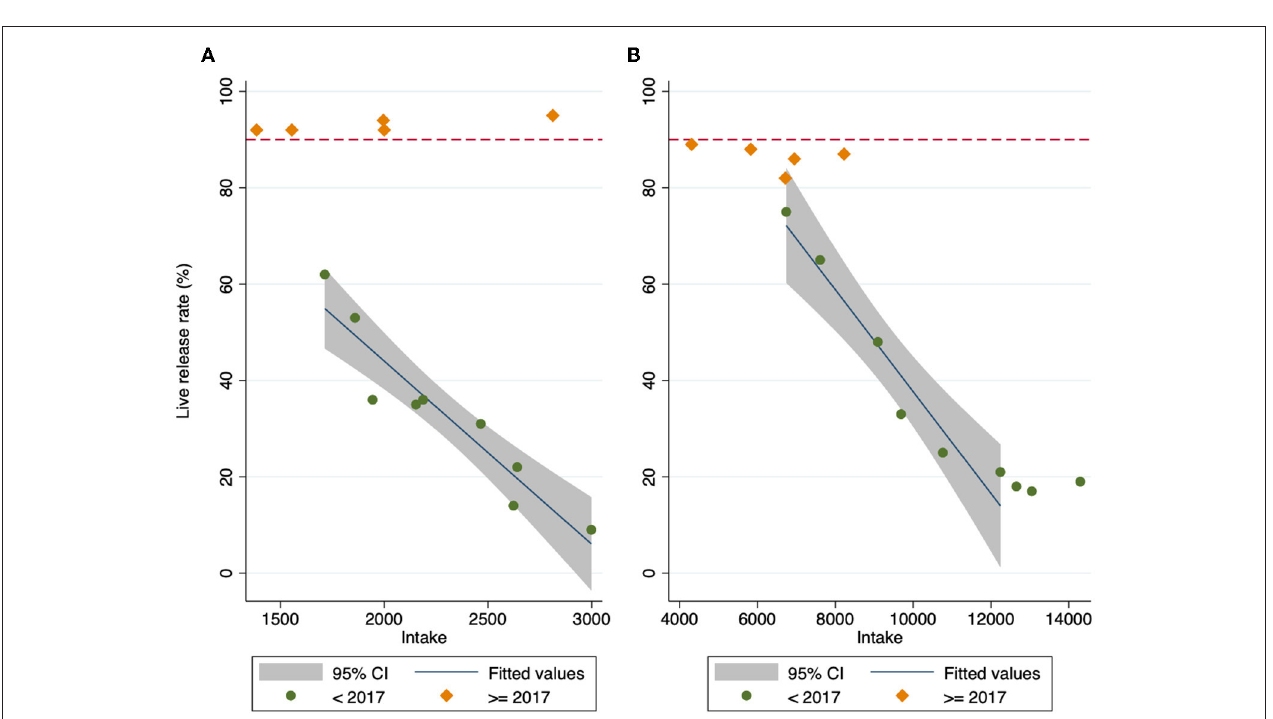
FIGURE 2 | Live release rate for cats (A) and dogs (B) by the number entering the shelter. Intake prior to the intervention year (2017) in green, and intake from 2017 onward in orange. Dotted line at 90%. The best fit line for cats shows a linear relationship between intake and live release rate prior to 2017, while there is no relationship between intake and live release rate after. The best fit line for dogs showed a curvilinear relationship between intake and live release rate prior to the intervention year, while there is no relationship between intake and live release rate after the intervention year.